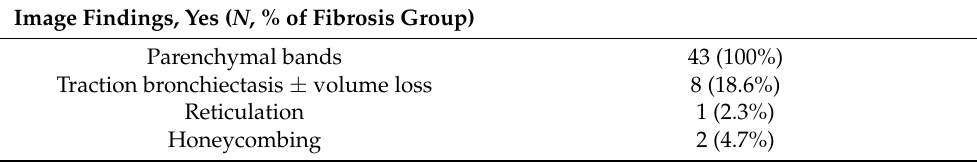
Table 4. Characteristic radiological findings according to the component of pulmonary fibrosis in chest CT